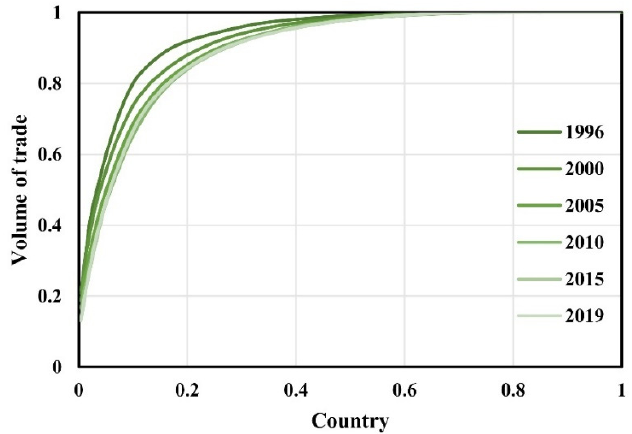
Figure 7. Accumulative distribution of the weights.